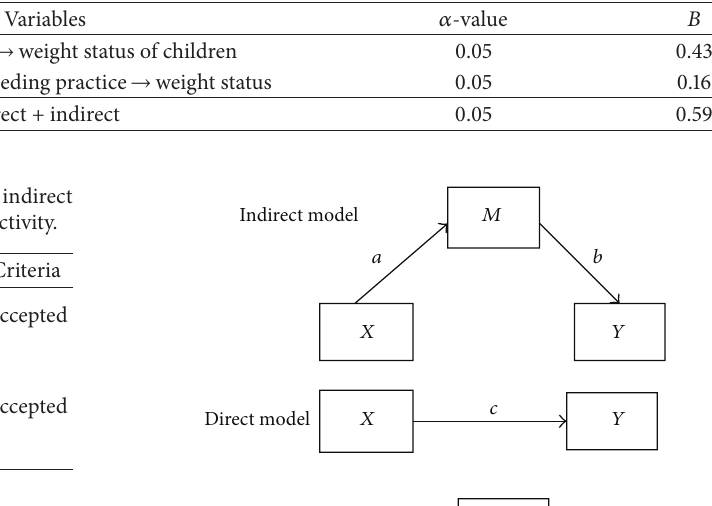
Table 10: Socioeconomic status related to weight status of children (through feeding practice).